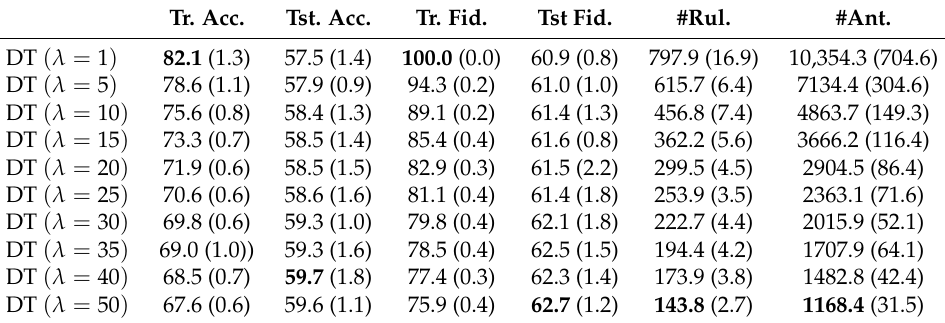
Table 4. Average results obtained by Decision Trees (DTs) trained to learn datasets with CNN targets, instead of true labels. Columns from left to right represent average results on: Training accuracy; predictive accuracy; fidelity on the training set; fidelity on the testing set; number of extracted rules; and number of antecedents in the rules. In the rows, the λ parameter controlling the size of the trees varies. Tr. Acc. Tst. Acc. Tr. Fid. Tst Fid. #Rul. #Ant.